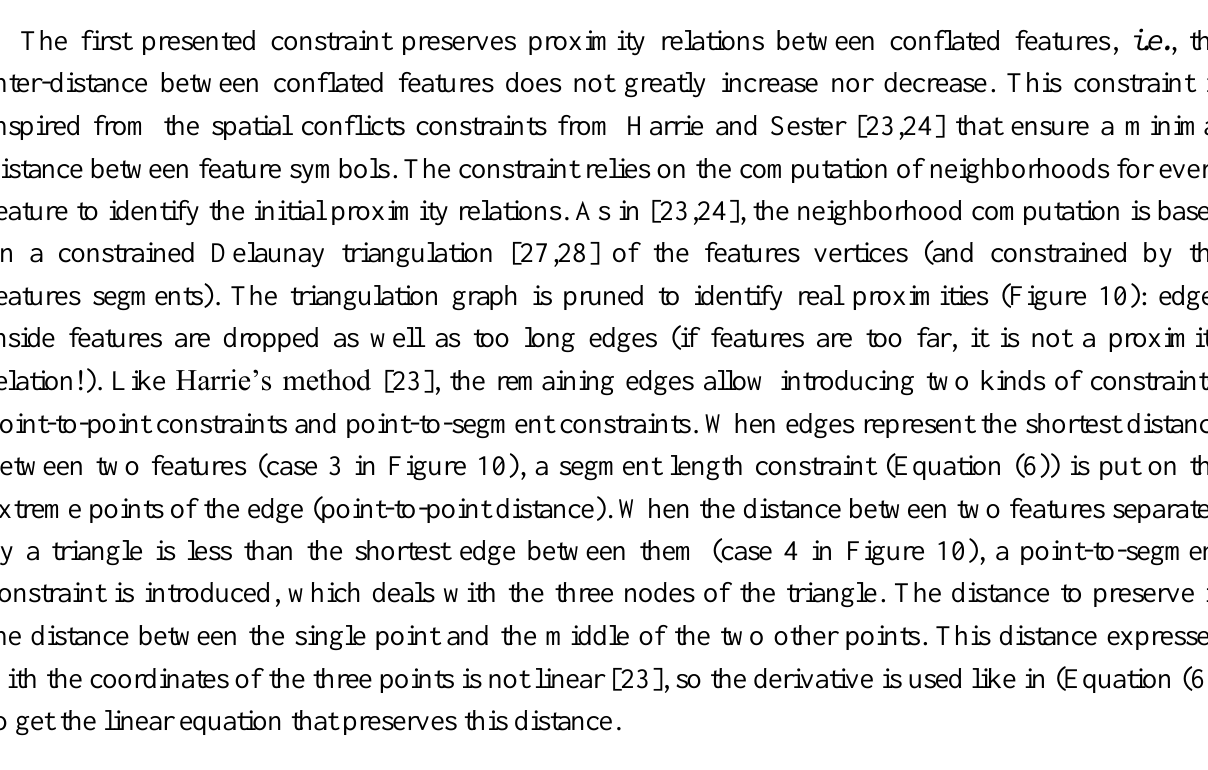
Figure 10. Constrained Delaunay triangulation used to identify proximities: ( 1 ) dashed edges dropped because inside objects, ( 2 ) edge dropped as distance > threshold, ( 3 ) black edges used for point-to-point proximity, ( 4 ) grey edges used for point-to-segment